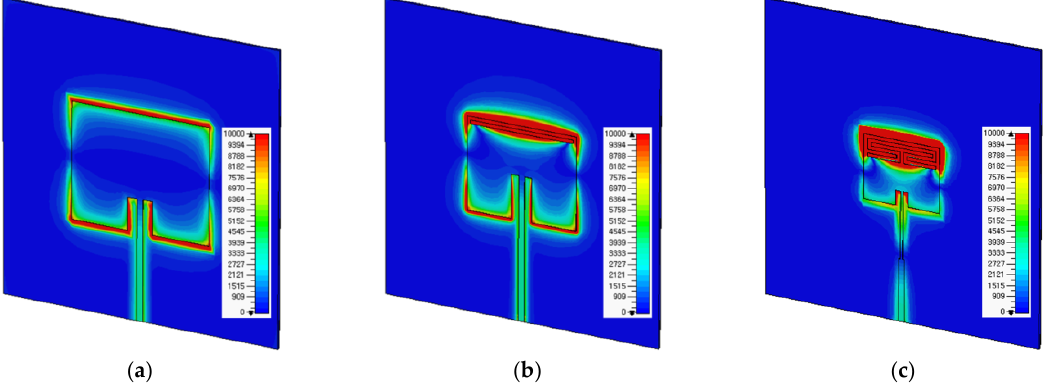
Figure 3. Electric field distributions at 2.5 GHz for ( a ) conventional MPSA; ( b ) RS-loaded MPSA; and ( c ) proposed MLS-loaded MPSA.